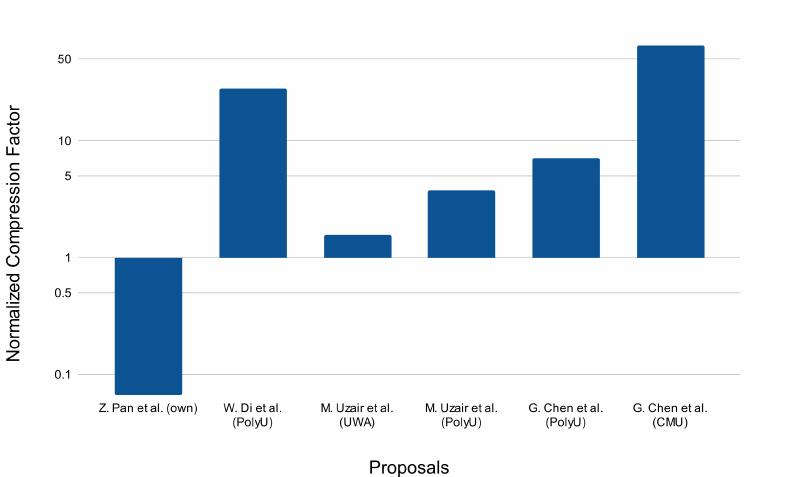
Figure 15. Normalized compression factor with respect to our proposal [24,28,29,32].